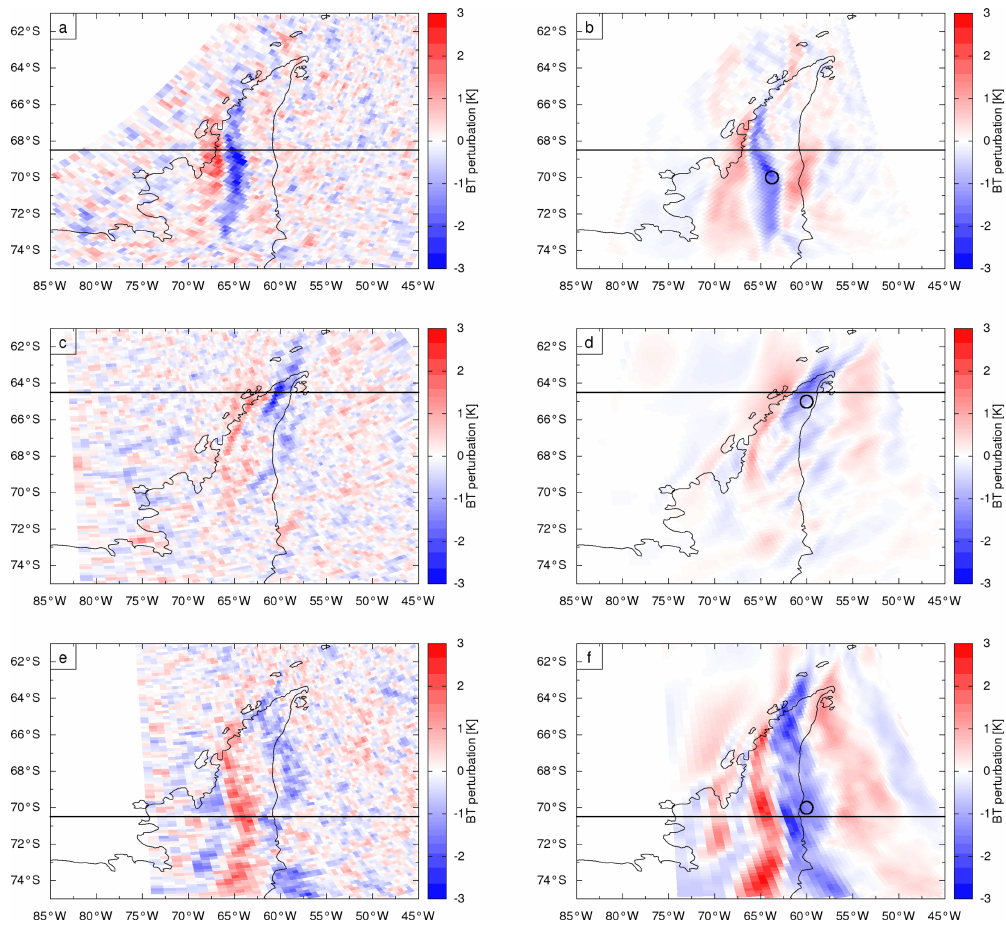
Figure 3. Measured (left) and mesoscale model (right) estimates of brightness temperature perturbations (K) over the AP corresponding to the 666.5cm − 1 AIRS channel at the time of the CS1 (a, b) , CS2 (c, d) , and CS3 (e, f) mountain wave events. See Table 1 for dates. The horizontal black lines indicate the latitude band selected for a more detailed comparison, shown in Fig. 4. The black circles in panels (b) , (d) , and (f) show the location of the climate model grid boxes used in Figs. 5, 7, and 8. Also shown is the coastline of the